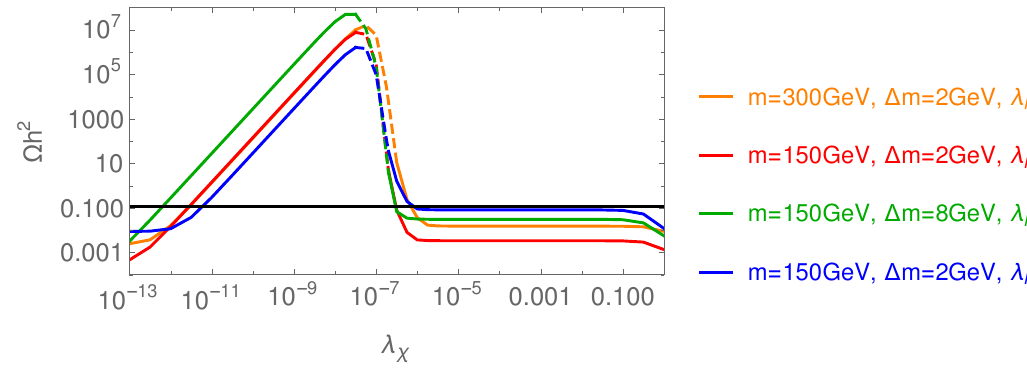
Figure 8 . DM abundance as a function of the Yukawa coupling (as in (cid:12)gure 2) for di(cid:11)erent values of the parameters m (cid:31) , (cid:1) m and (cid:21) H .